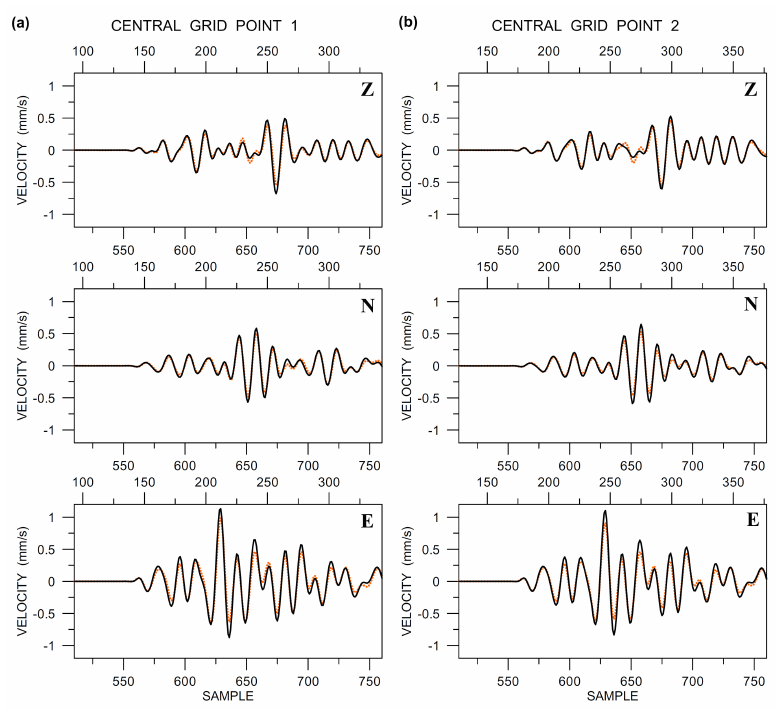
Figure 13. Comparison of the LE-3DLite (dotted orange) and Rotaphone (solid black) translational components (vertical Z, North N, and East E) at the central grid points 1 ( a ) and 2 ( b ). Data are band-pass filtered between 6 and 20 Hz and instrument-corrected. The sampling frequency was 250 Hz.